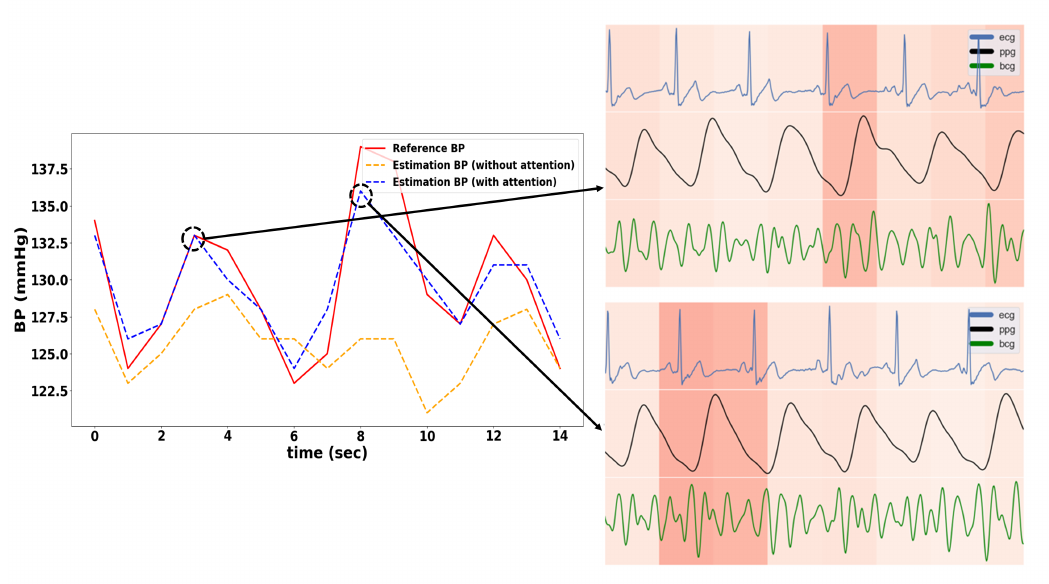
Figure 9. Left: Sample of the estimated BP with and without attention mechanism; Right: Heat map of the weights of the attention mechanism at the point where the error was low. The darker color denotes higher attention